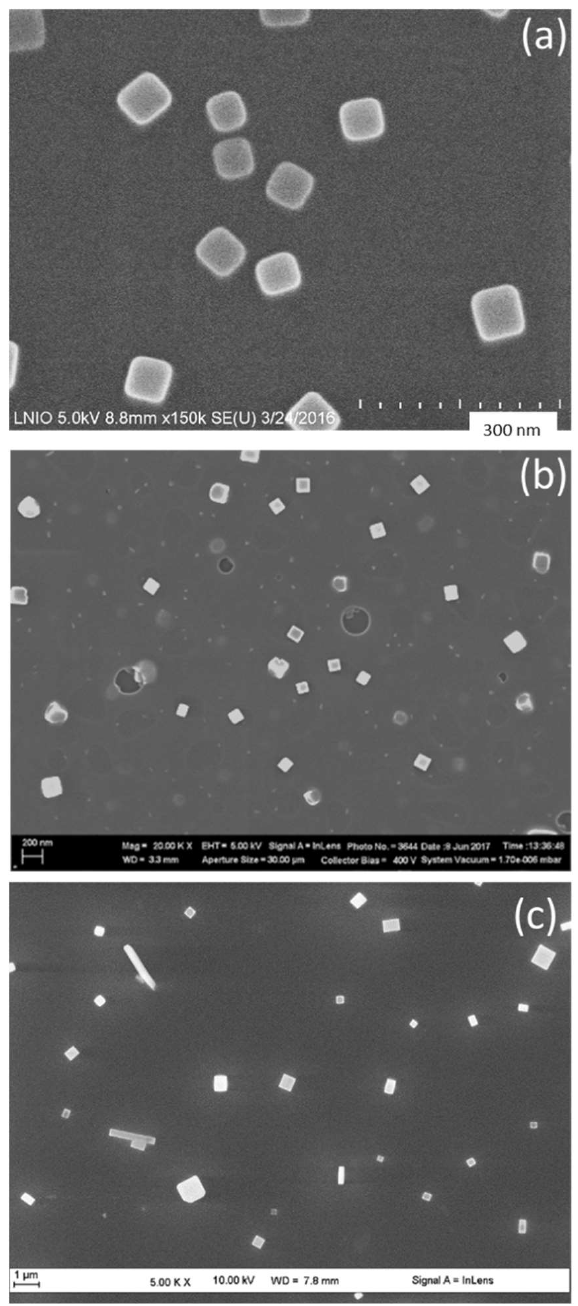
Figure 2. SEM images for Gold nanoparticles obtained with NaAuCl 4 ·2H 2 O precursor and various solvent/non-solvent compositions. ( a ) Acetone/ethanol, ( b ) MIBK/ethanol, and ( c ) acetone/isopropanol.